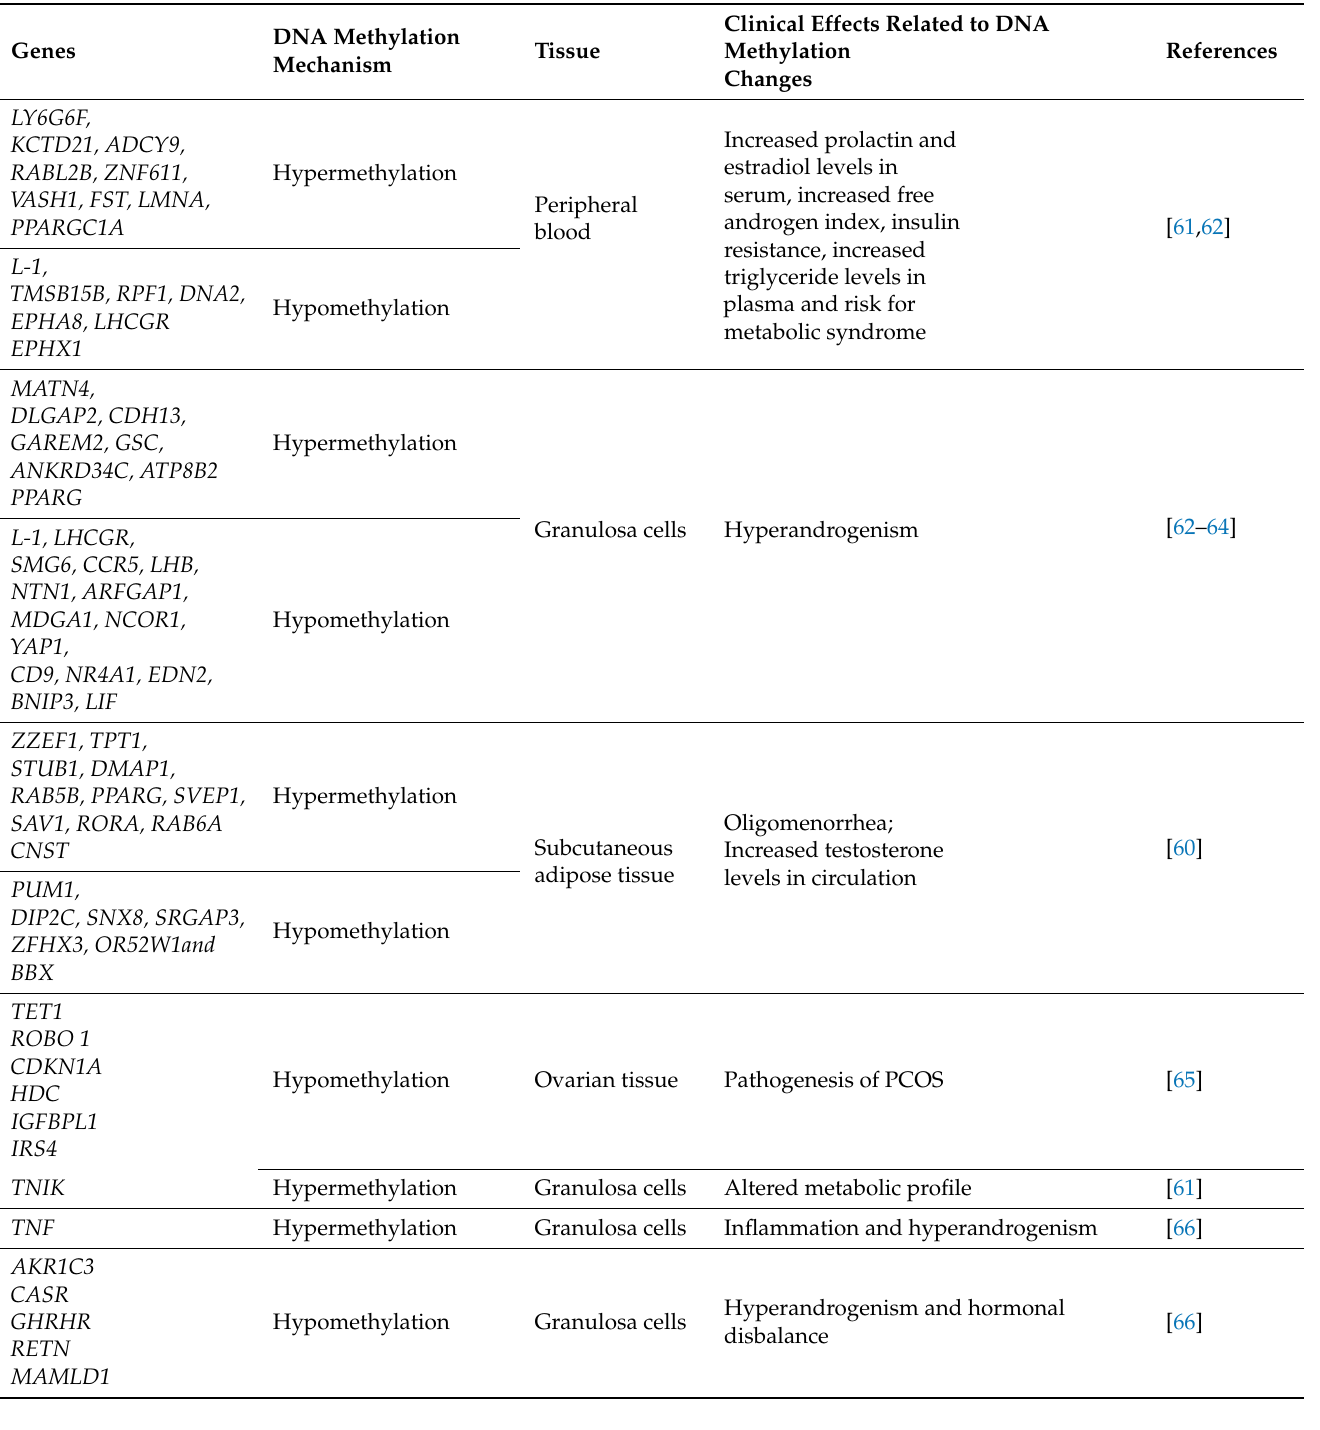
Table 3. Differentially methylated genes reported in tissues from patients with